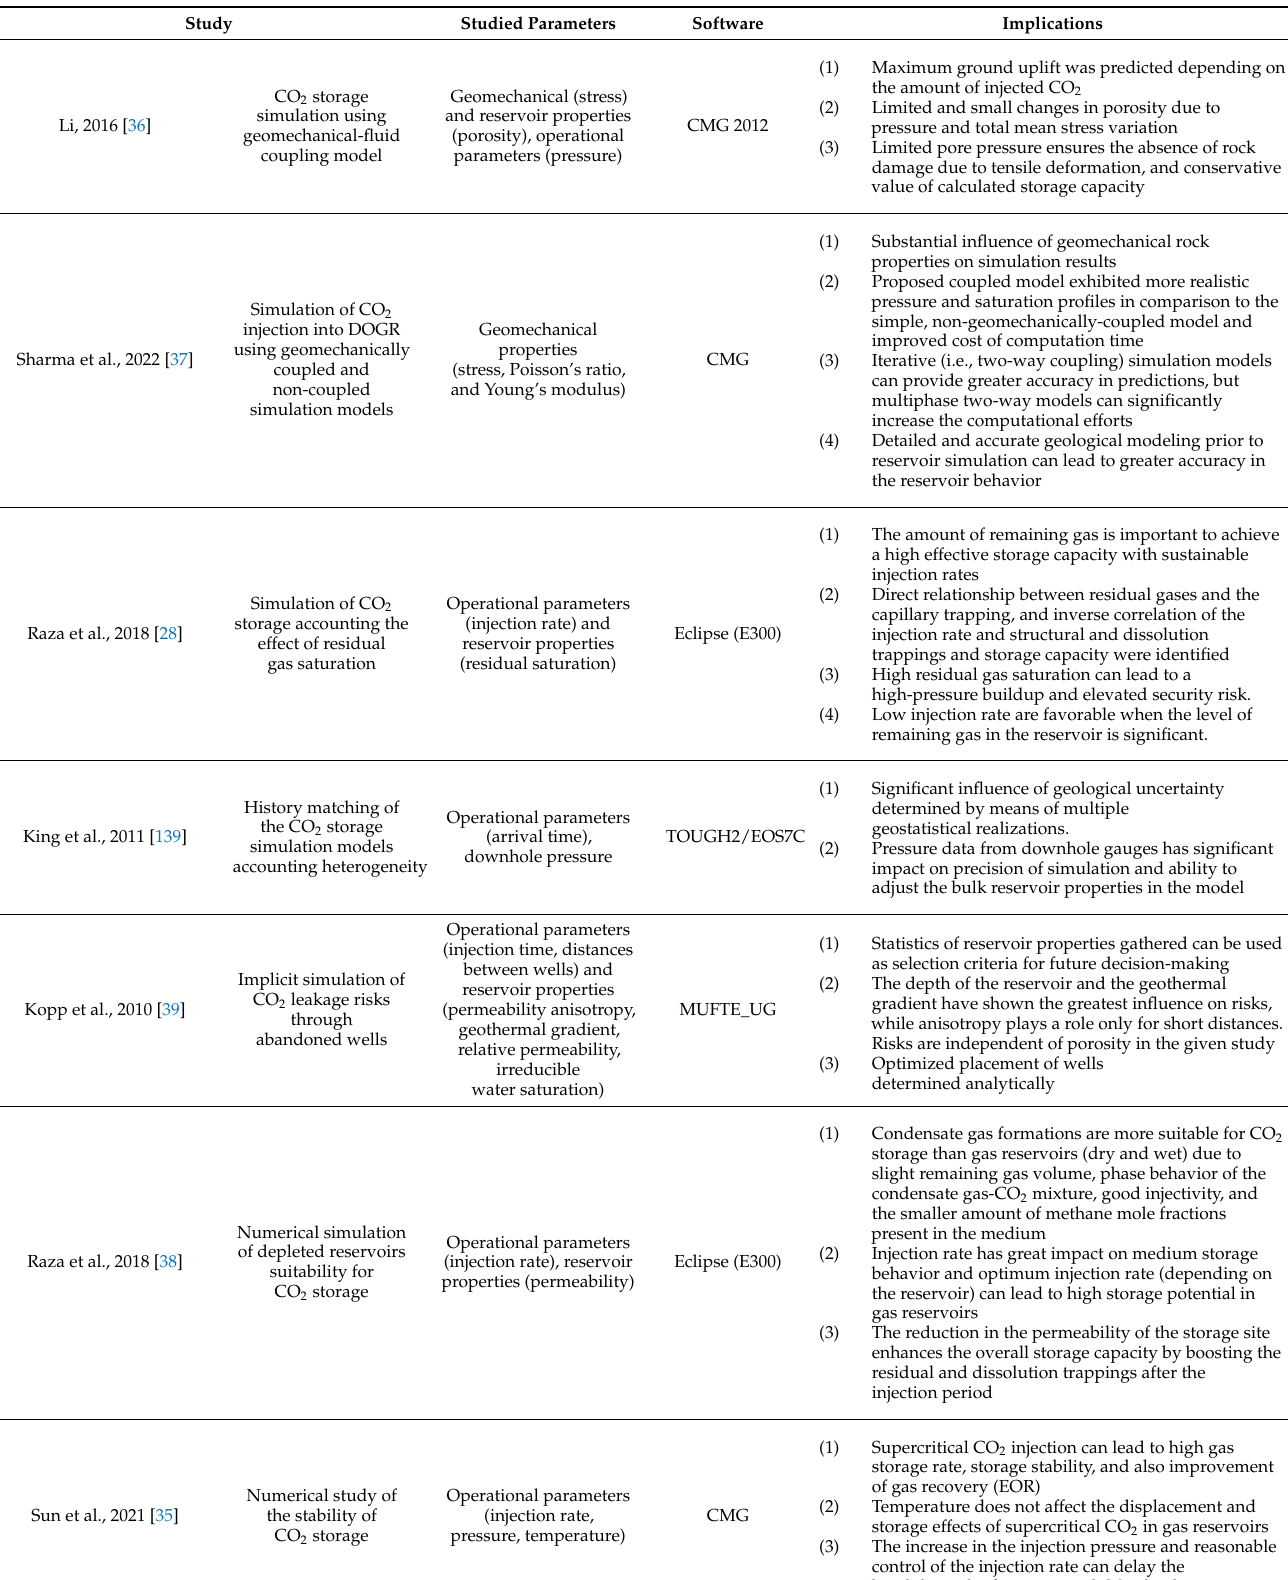
Table 2. Summary on numerically studied parameters affecting CO 2 storage in